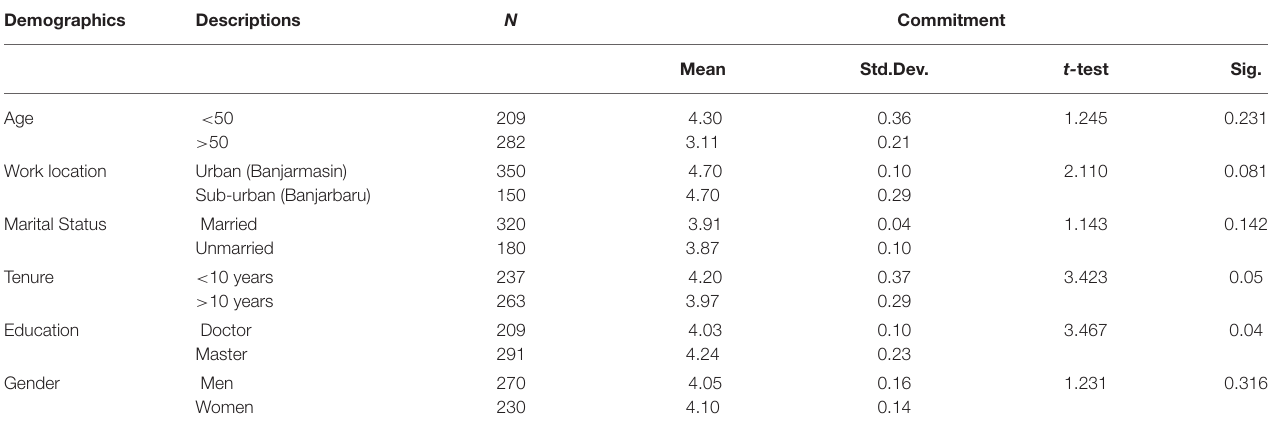
TABLE 2 | Summary of t